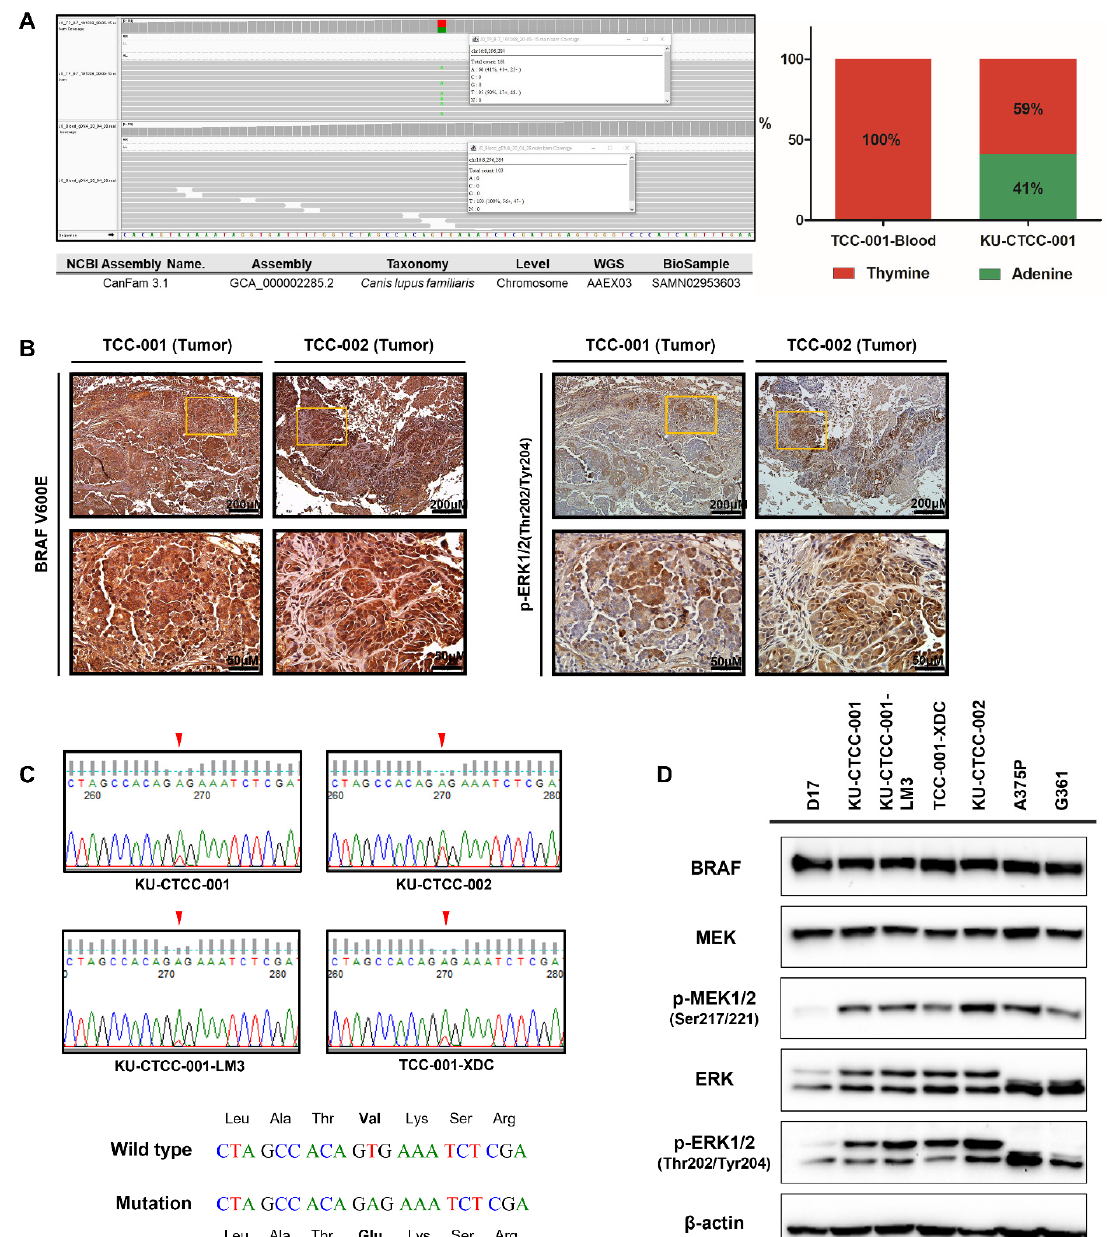
Figure 2. Detection of BRAF V595E mutations and MAPK pathway activation. ( A ) Somatic variant-calling results of the BRAF gene in KU-CTCC-001. In contrast to the blood results, KU-CTCC-001 cells showed heterozygous mutations. Wild-type (thymine) reads were mapped to the reference sequence more than mutant (adenine) reads. The ratio of wild-type to mutants was 59:41. ( B ) Immunohistochemical (IHC) staining of BRAF mutations and phosphorylated ERK1/2 protein. Tumor tissues were strongly stained with anti-BRAF V600E antibody, suggesting the presence of V595E mutations. Phosphorylated ERK1/2 protein was also highly expressed in the tumor tissues. ( C ) Detection of BRAF V595E mutations by Sanger sequencing. Heterozygous mutations were confirmed not only in KU-CTCC-001 cell lines but also in the other cell lines. Furthermore, tumor-dissociated cells derived from the xenograft mouse model injected with KU-CTCC-001 cells (TCC-001-XDC) showed a similar ratio of wild-type to mutants as the original cell line (KU-CTCC-001). ( D ) MAPK pathway activation at the protein level. The expression of phosphorylated MEK1/2 protein and phosphorylated ERK1/2 protein was similar to that of human BRAF V600E mutant cell lines (A375P and G361) and higher than that of the D17 cell line.